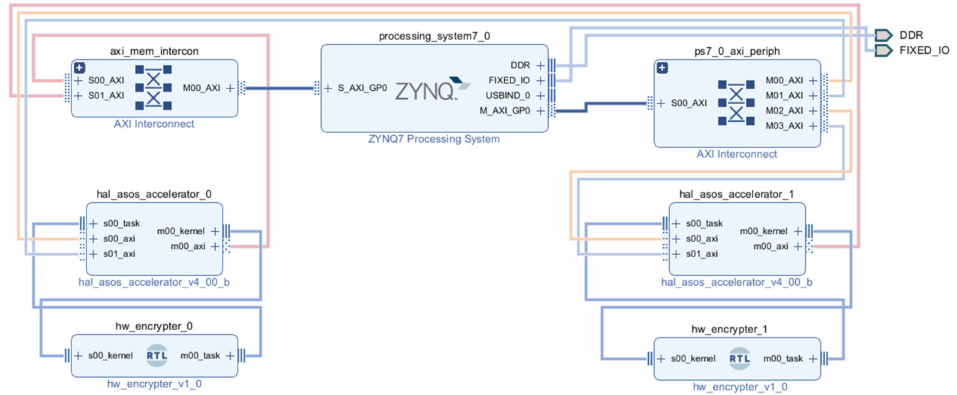
Figure 7. The simplified block design of the internet application using the ZC702 evaluation